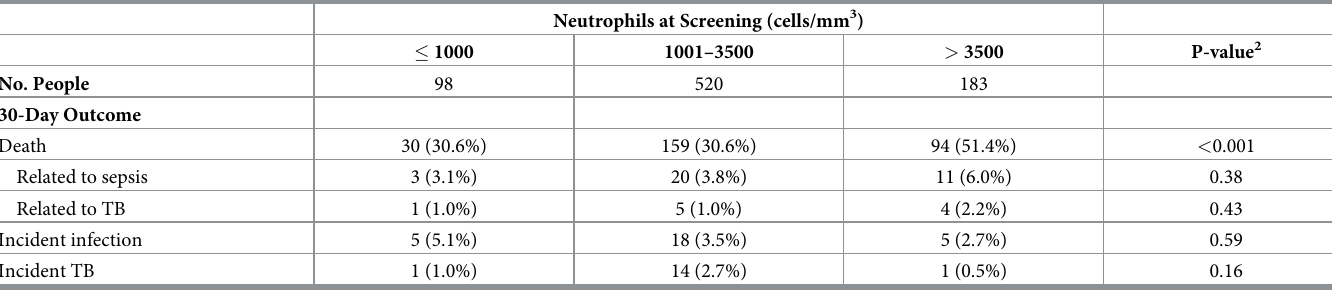
Table 2. Thirty-day outcomes 1 by neutrophil group.